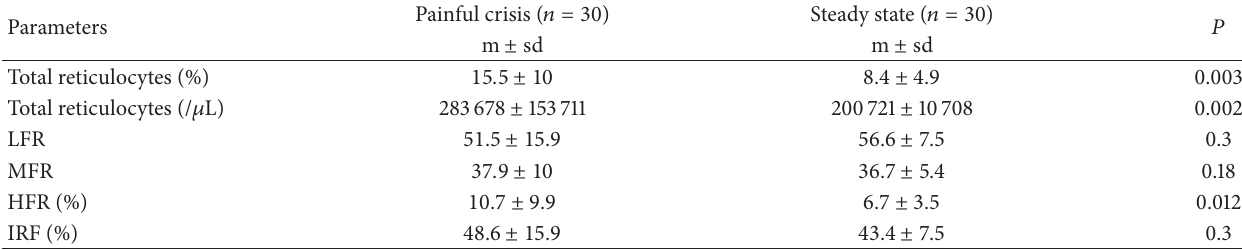
Table 2: Distribution of reticulocytes according to their degree of maturity and to the clinical status.